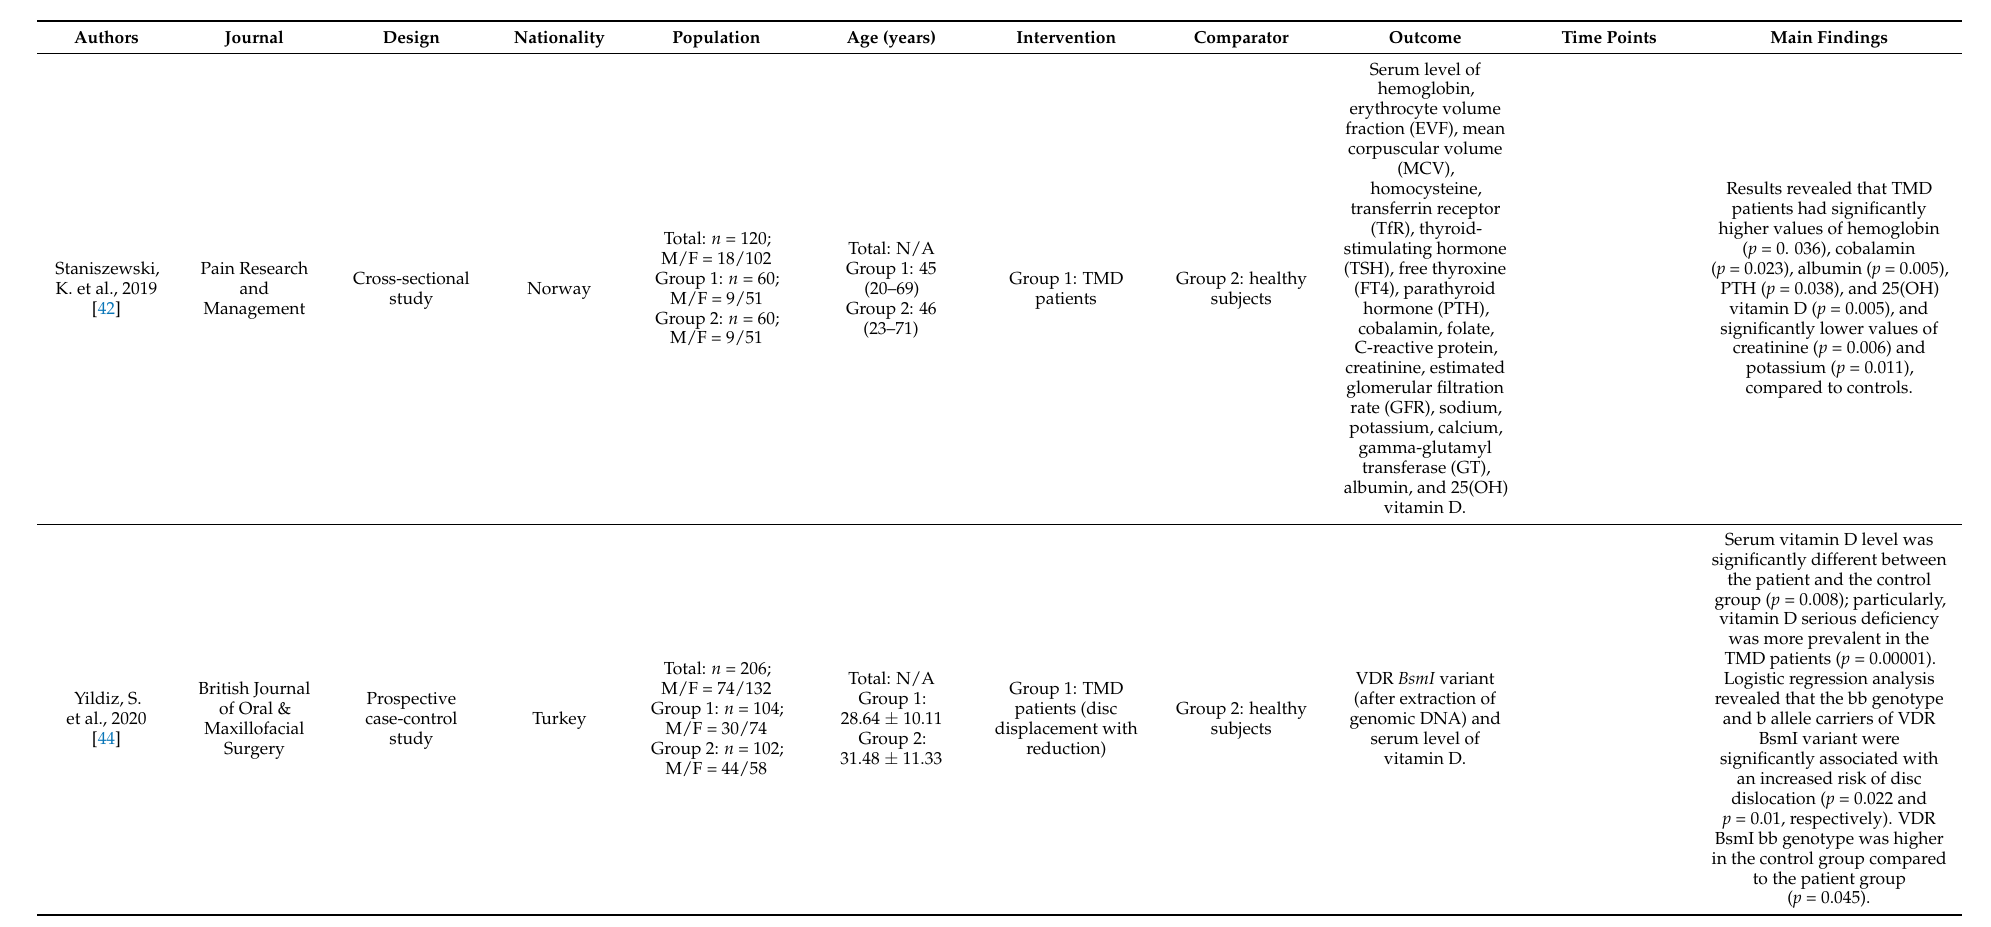
Group 1: TMD patients (disc displacement with reduction)